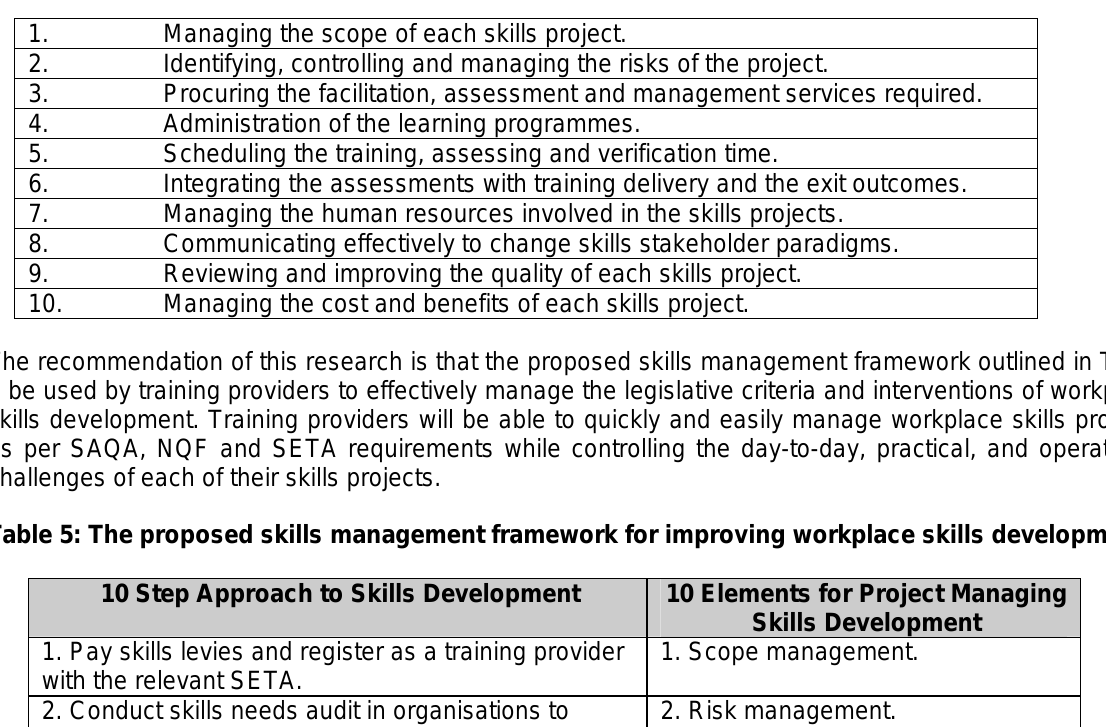
Table 4: Managing skills interventions as projects